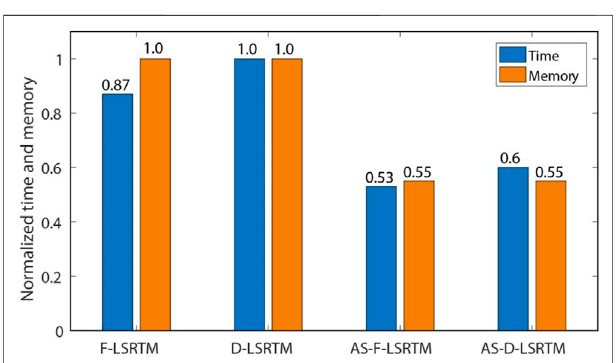
FIGURE 14 | Computing time and memory requirement of the four methods.